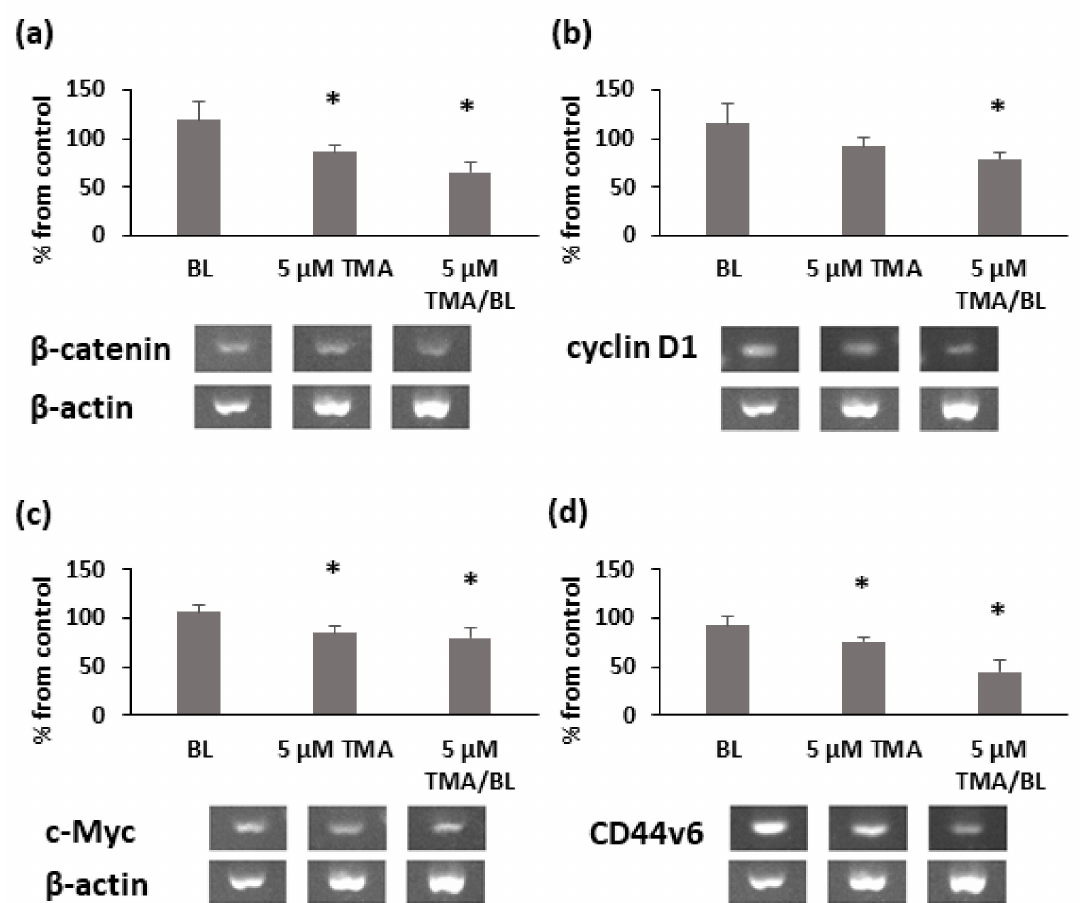
Figure 5. RT-PCR analysis of β -catenin ( a ), cyclin D1 ( b ), c-Myc ( c ), and CD44v6 ( d ) at 3h after the treatment with TMA/BL (2 J/cm 2 ). Quantification of the expression levels was carried out by a densitometric analysis using ImageLab software. Data were reported as percentages from the control cultures. * = p < 0.05 vs. control cultures, Student’s t